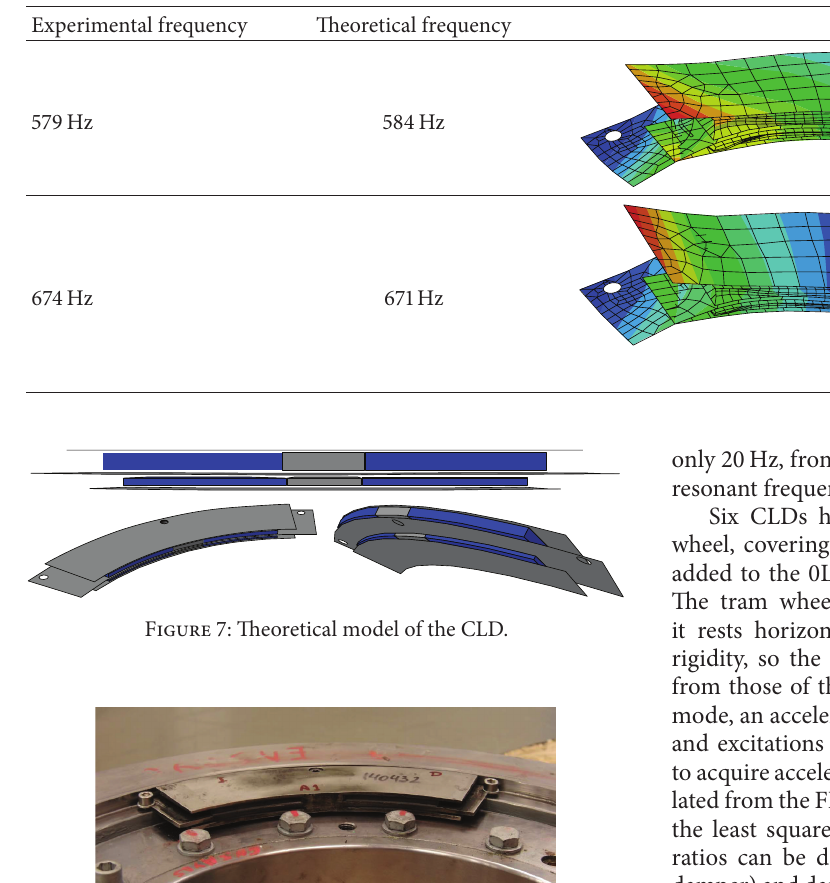
Table 1: Experimental and theoretical eigenfrequencies of the CLD.